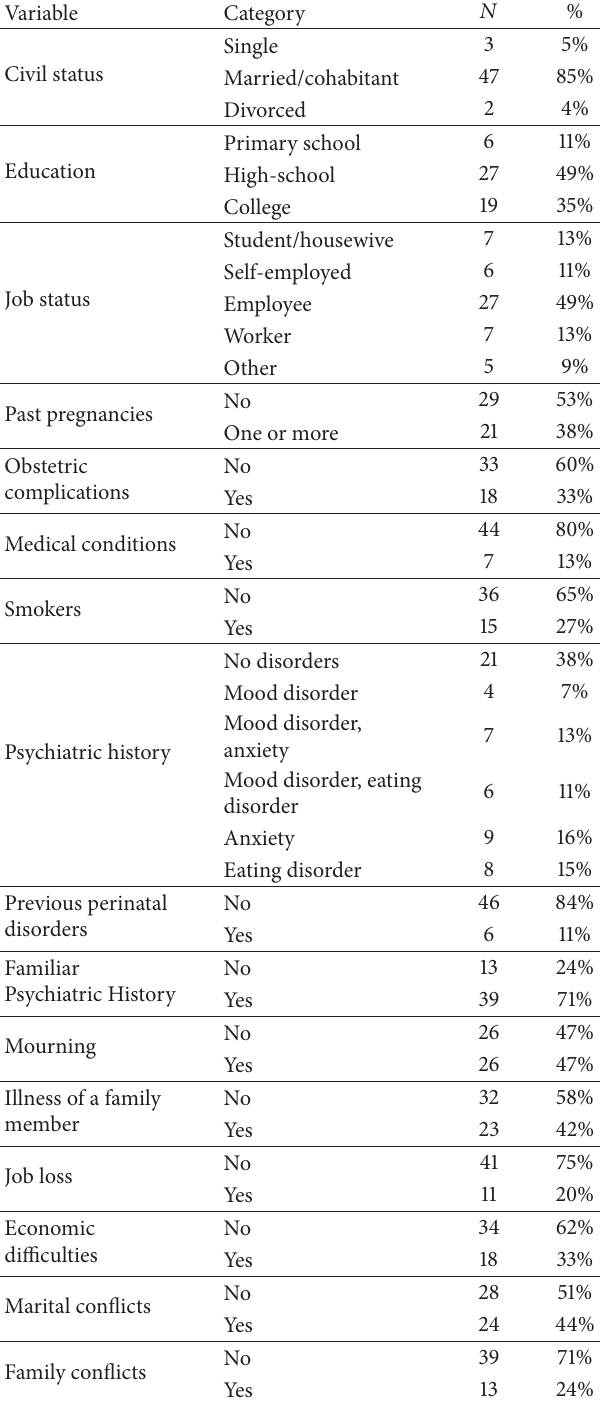
Table 1: Characteristics of the study population.